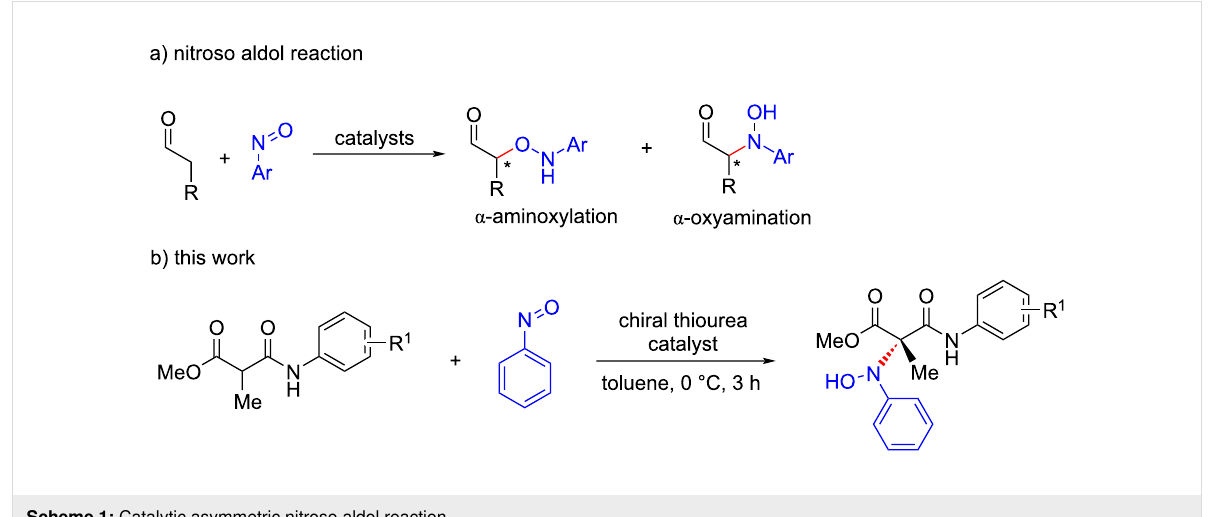
Scheme 1: Catalytic asymmetric nitroso aldol